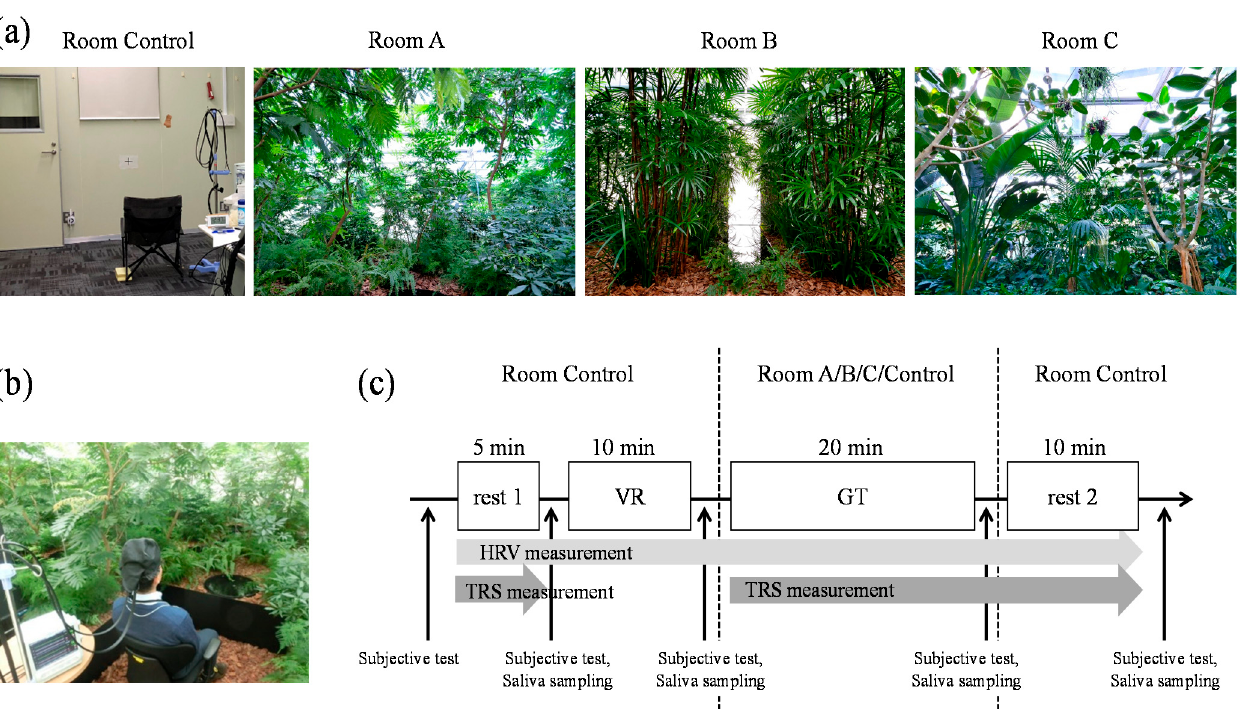
Figure 2. Experimental procedure. ( a ) Scene during staying spaces. ( b ) State at the time of measurement. ( c ) Study protocol. TRS, time-resolved spectroscopy; VR, visual reality; HRV, heart rate variability; GT, test space; Room Control, space without natural green features; Room A/B/C, space with natural green features.